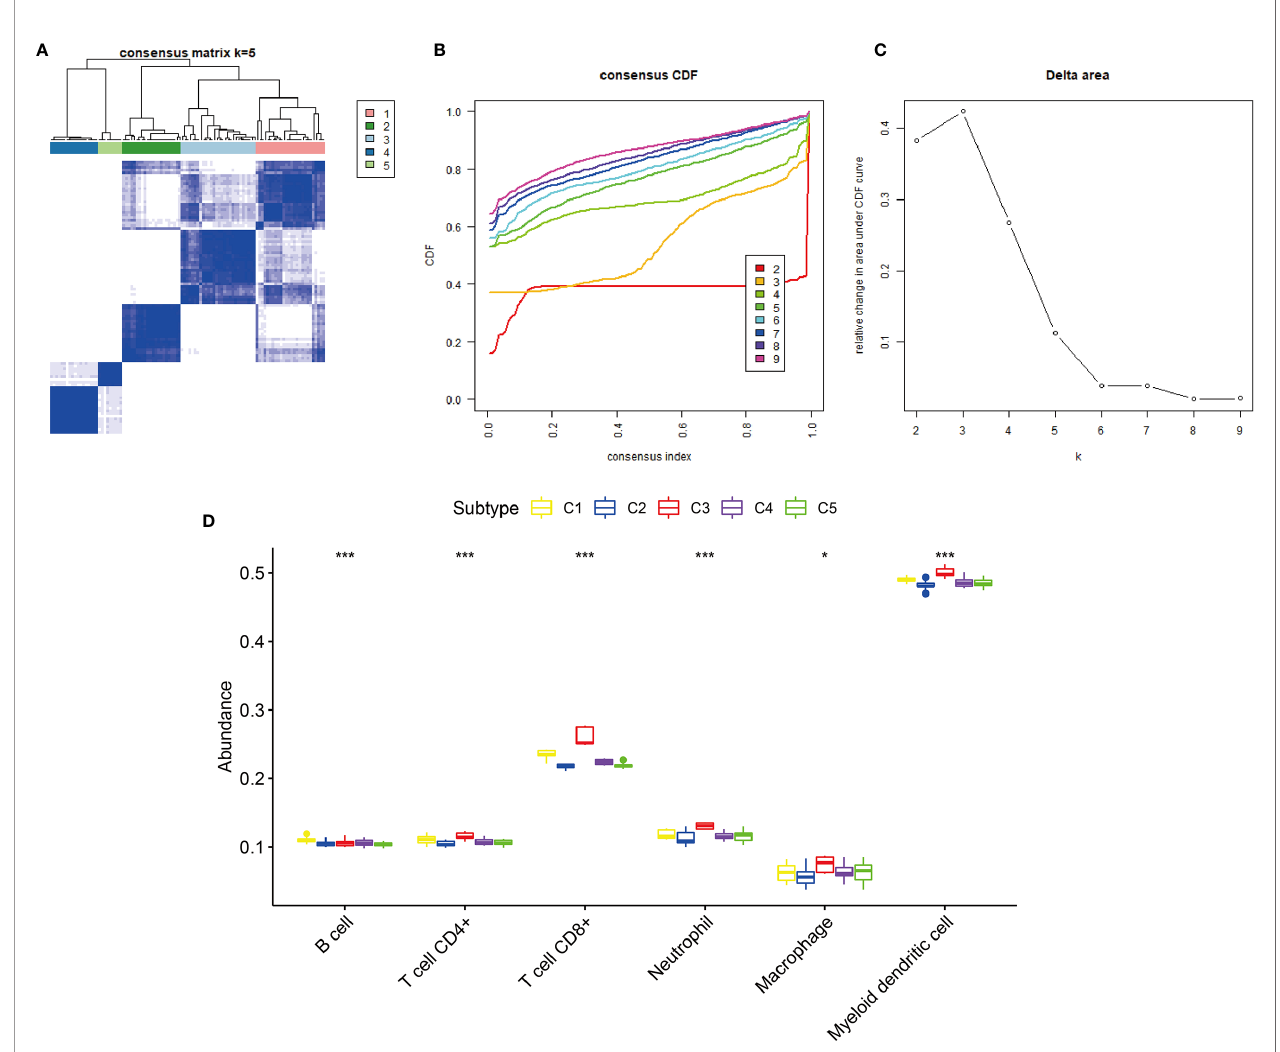
FIGURE 8 | Consensus clustering of KIRP samples in the GEO cohort. (A) Heat map of sample clustering at k = 5. (B) Cumulative distribution function (CDF) curve for k = 2 – 9. (C) Relative change in area under the CDF curve when k = 2 – 9. (D) The abundance of six immune cells among fi ve immune subtypes, ***p < 0.001, *p >